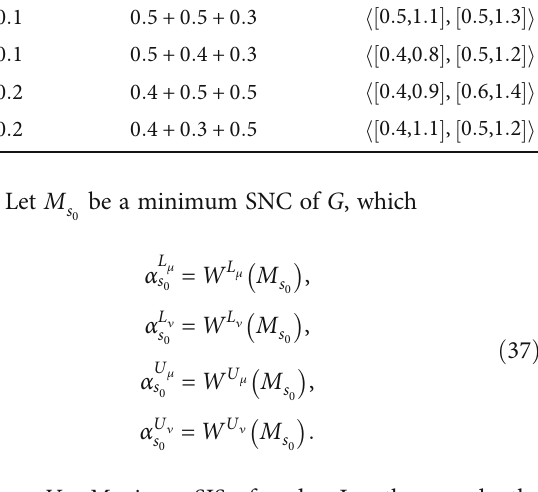
= h½ 0 : 4,1 (cid:2) , ½ 1 : 1,1 : 4 (cid:2)i . s 1